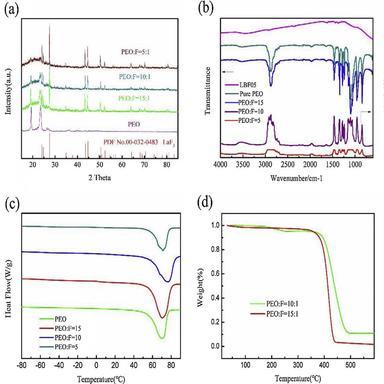
(a) XRD of the pure PEO and LBF05@PEO electrolytes; (b) FT-IR spectra of the LBF05 powders, pure PEO and LBF05@PEO electrolytes; (c) DSC curves of the pure PEO and LBF05@PEO electrolytes; (d) TGA curves of the LBF05@PEO electrolytes.